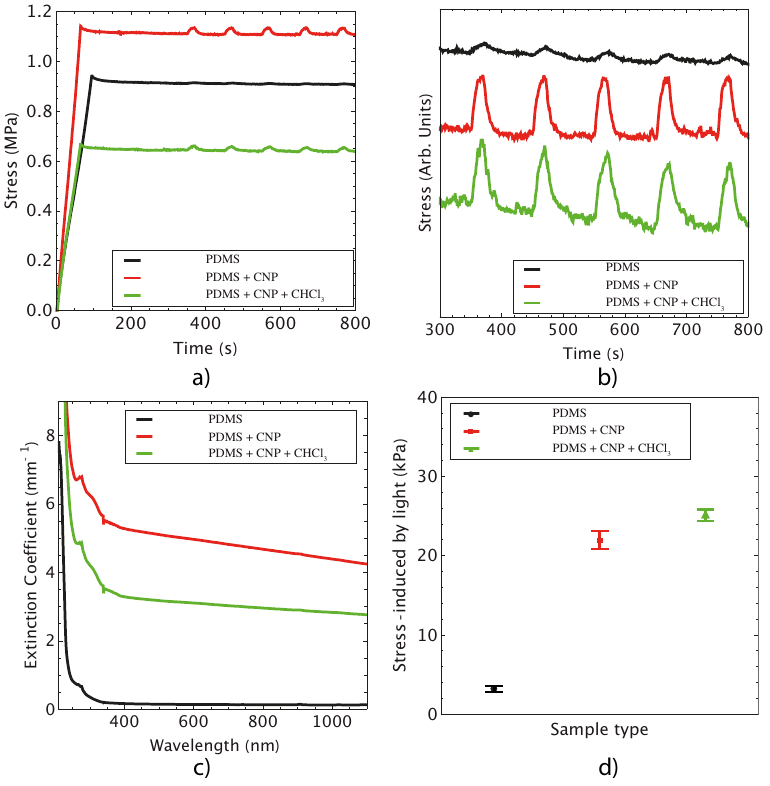
Figure 6. Laser induced mechanical stress in PDMS composites. ( a ) experimental curves showing the stress relaxation as function of time for PDMS and its composites; ( b ) peaks evidencing the photo-actuation capabilities of these composites; ( c ) extinction coefficient as a function of wavelength for PDMS and composites; and ( d ) photomechanical actuation of PDMS and composites.